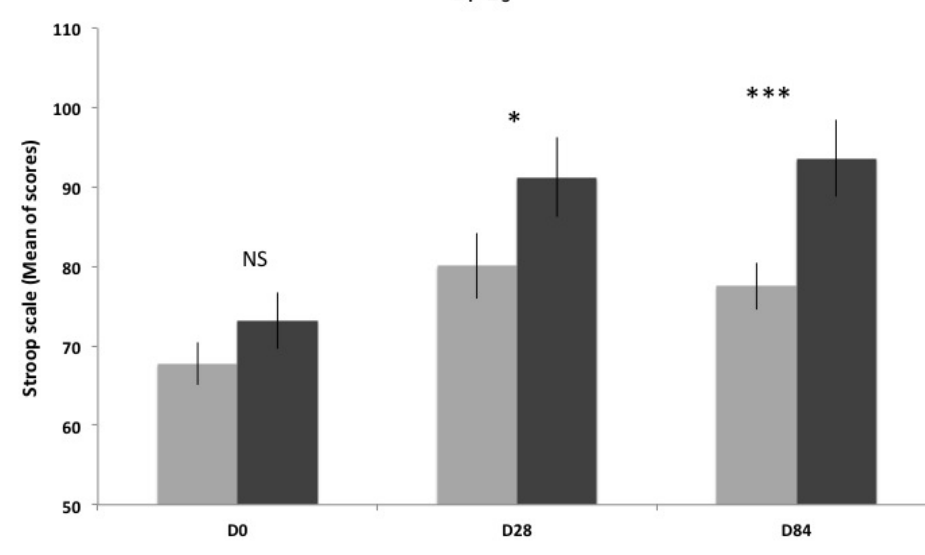
3. Scores of Stroop scale (Mean ± SEM) before, between and after supplementation. Transverse comparison between groups are not significantly different